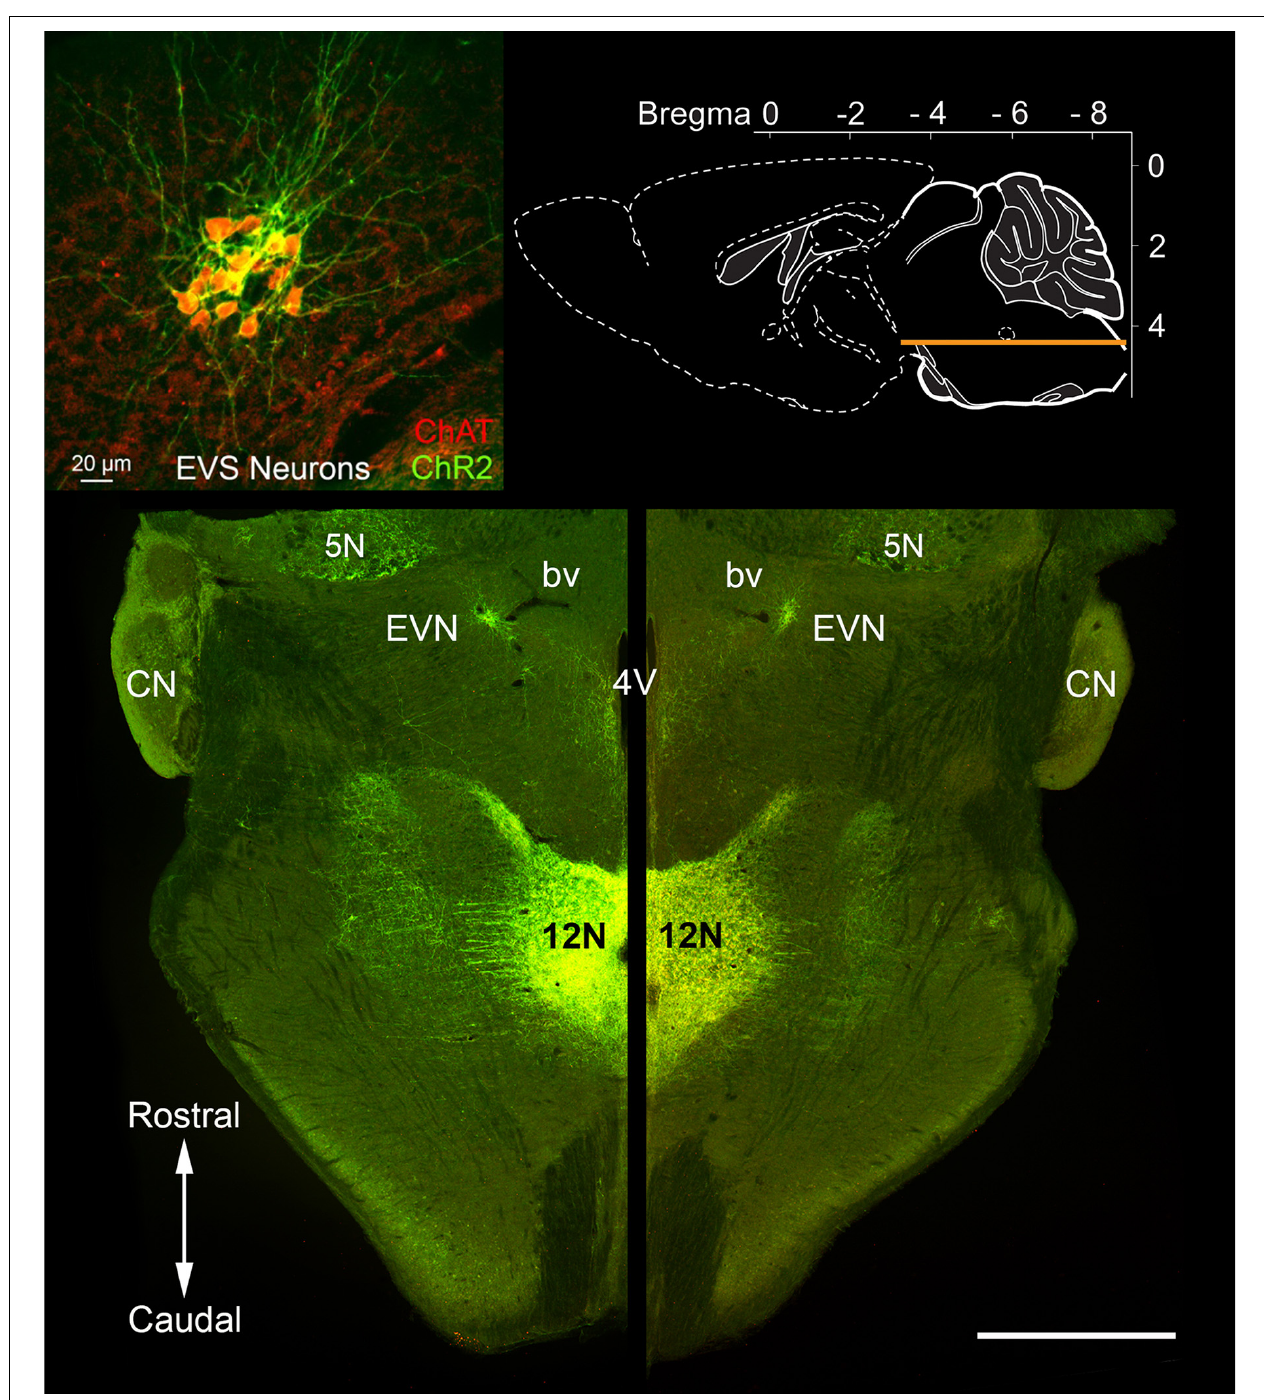
FIGURE 2 | Rostrocaudal location of the Efferent Vestibular Nucleus (EVN). A horizontal section through the brainstem (see top right inset) of a Chat-ChR2 mouse, where enhanced yellow fluorescent protein (EYFP) and the light-sensitive channels, Channelrhodopsin-2 (ChR2), are co-expressed in cholinergic neurons. The tightly packed Efferent Vestibular Nucleus (EVN) neurons, which are the source of efferent input to the vestibular periphery, are fluorescently labeled and localized at the same level as the floor of the fourth ventricle (4V). EVN neurons were confirmed as cholinergic by double-labeling with antibodies against EYFP (ChR2) and choline acetyltransferase (ChAT), the enzyme responsible for the synthesis of acetylcholine. There was a complete overlap of the two labels as shown in the top-left inset. Similar one-to-one overlap was also observed with our Chat-gCaMP6 f mouse strain. A characteristic feature seen in both horizontal and transverse slices is the close association between the EVN and nearby blood vessels (bv) as can be seen on both left and right sides. CN = Cochlea Nucleus; 5N = Trigeminal nucleus; 12N Hypoglossal nucleus. Scale bar: 1 mm.